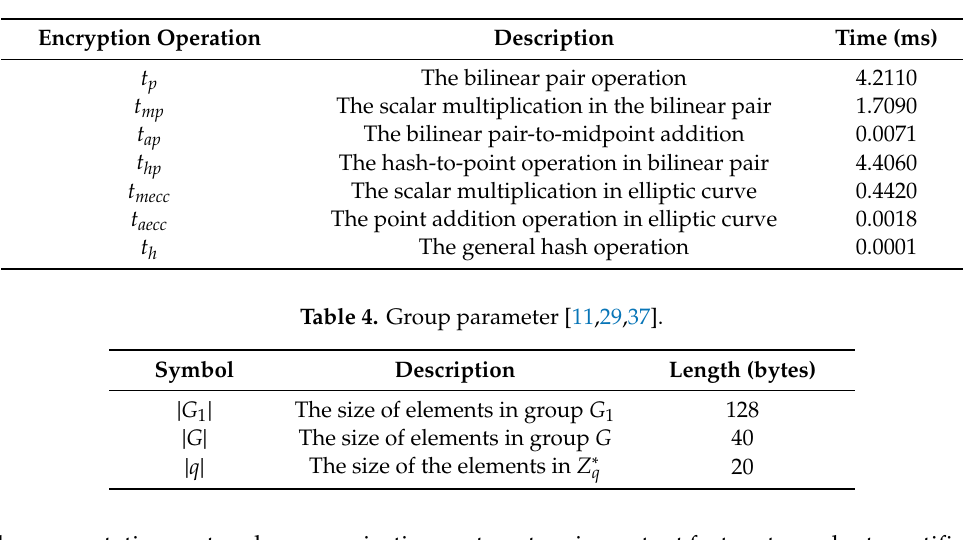
Table 3. Di ff erent encryption operation running time [11,29,37].